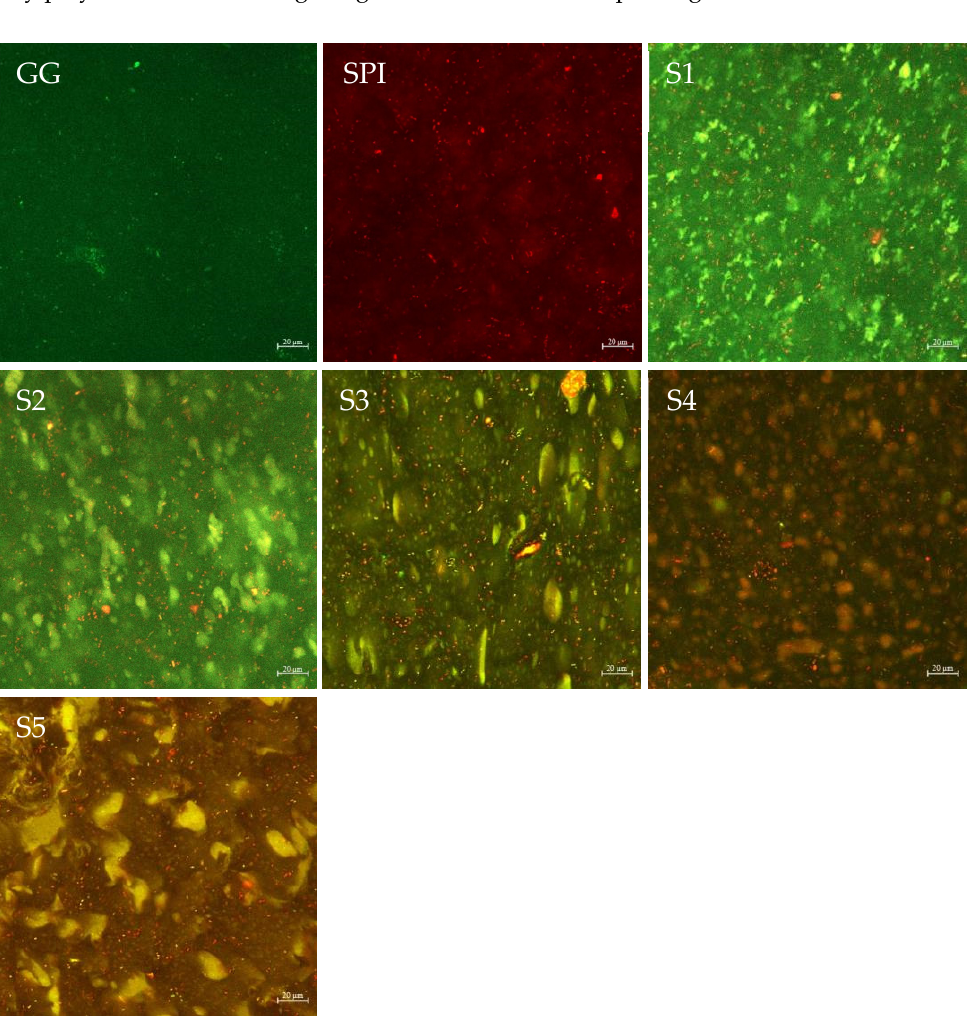
Figure 6. Effect of different SPI content on laser confocal microscopy of GG-SPI complex gel. The scale bars correspond to 20 μ m.